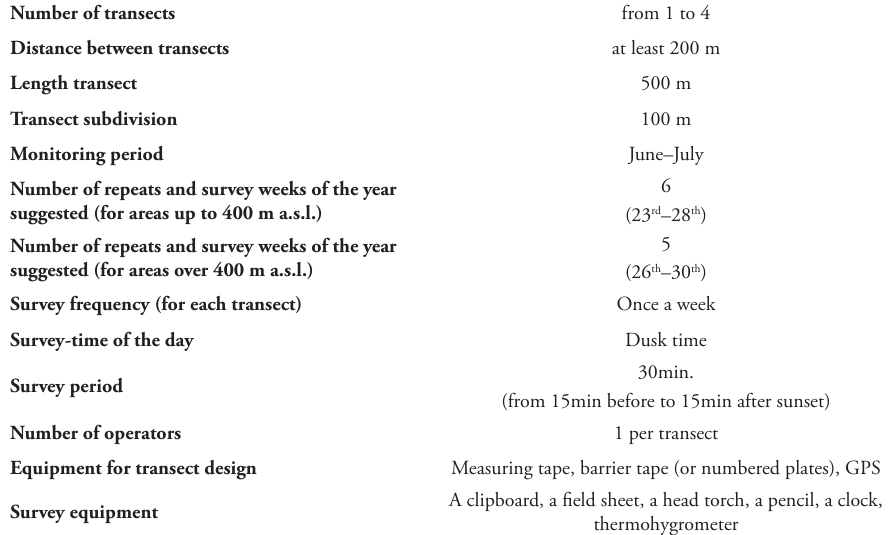
Table 8. Summary of the main aspects of the monitoring method Sighting individuals along transect at dusk. Number of transects from 1 to 4 Distance between transects at least 200 m Length transect 500 m Transect subdivision 100 m Monitoring period